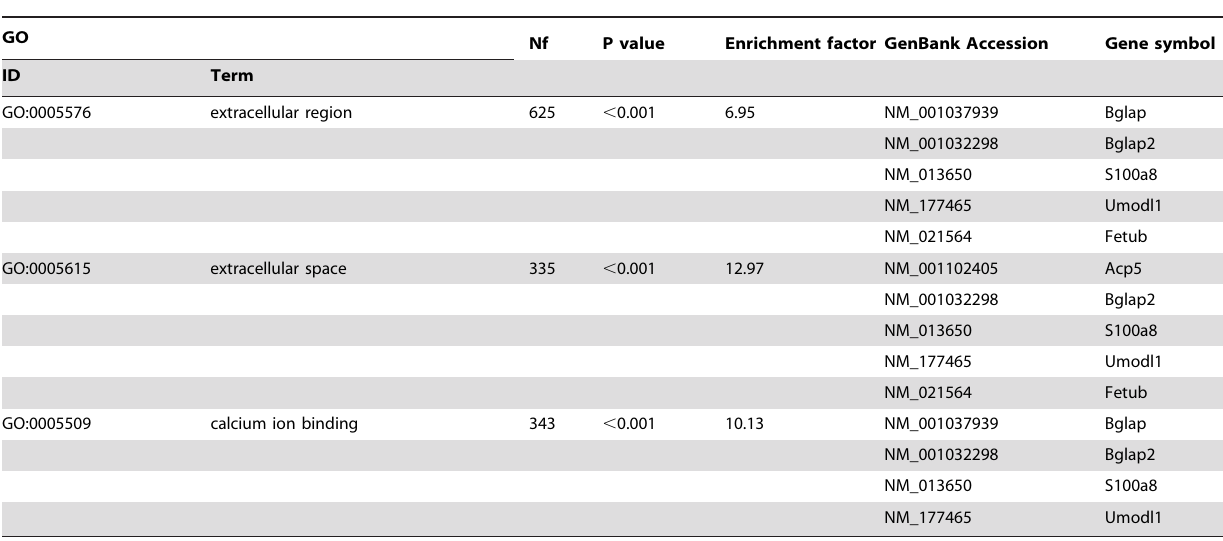
Table 5. Functional analysis of cluster B using Gene Ontology